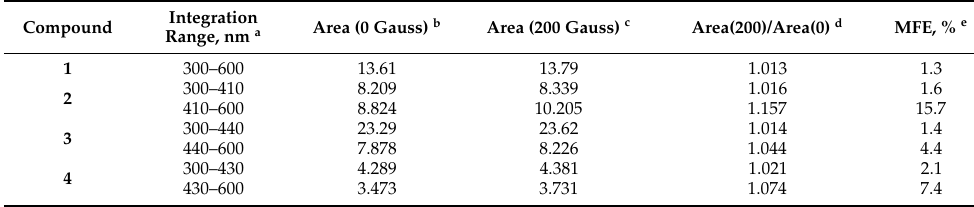
Table 2. Magnetic field effect on local emission/exciplex emission